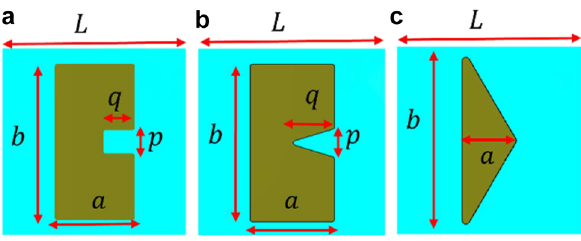
Figure 1: Definition of parameters for (a) SRR Au-DRM. (b) Heptag- onal Au-DRM. (c) Triangular Au-DRM.